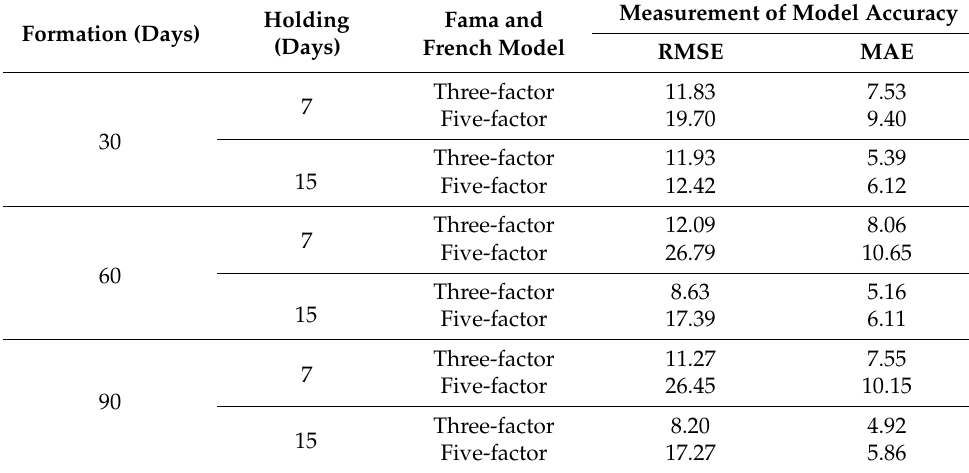
Table 4. A comparison of the three-factor and five-factor models.